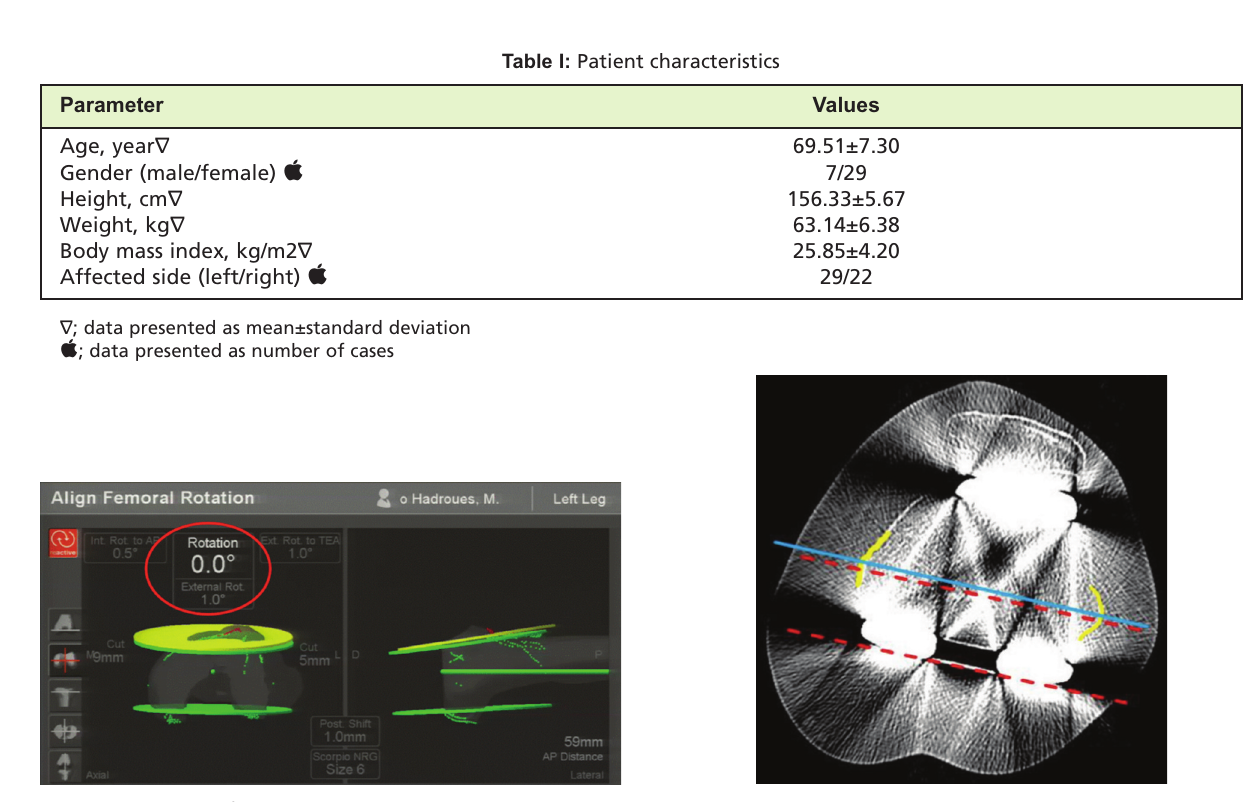
Screenshot of computer-assisted navigation showing the Fig. 1: intra-operative registration record of the femoral component rotation (CAN-FRA).